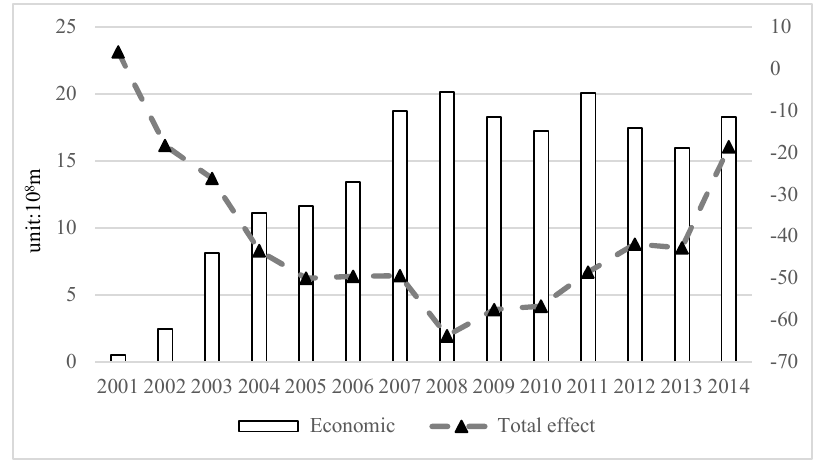
Figure 7. Relationship between per capita Gross Domestic Product (GDP) and total virtual water exports.